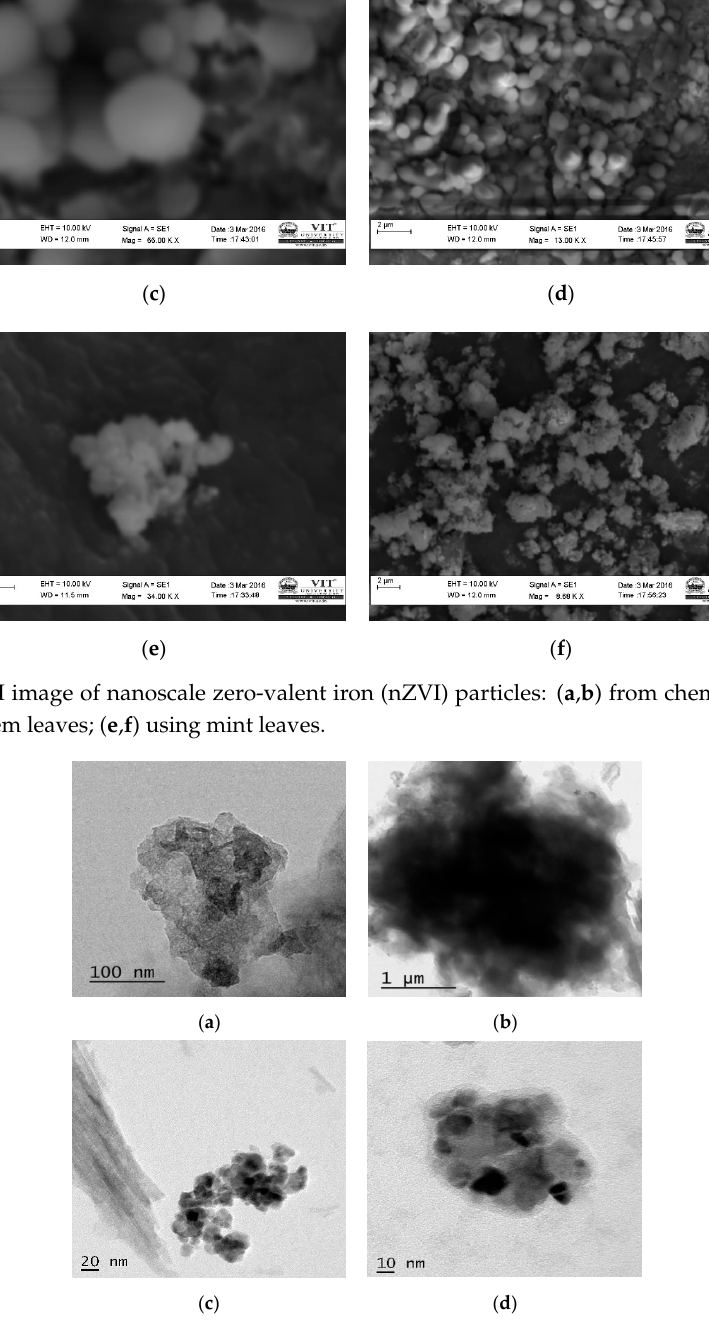
Figure 2. TEM image of nZVI particles: ( a , b ) chemically synthesized; ( c , d ) using neem leaves; ( e , f ) using mint leaves.